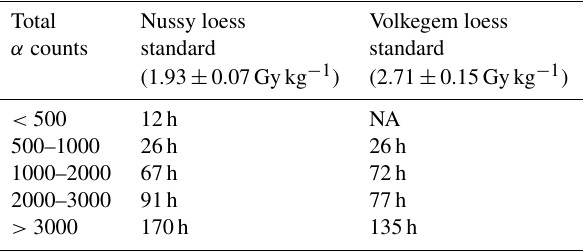
Table D1. Relation of total alpha counts to measurement duration for the Nussy and Volkegem loess standards. Given values repre- sent mean values derived from all measurements on three different µ Dose